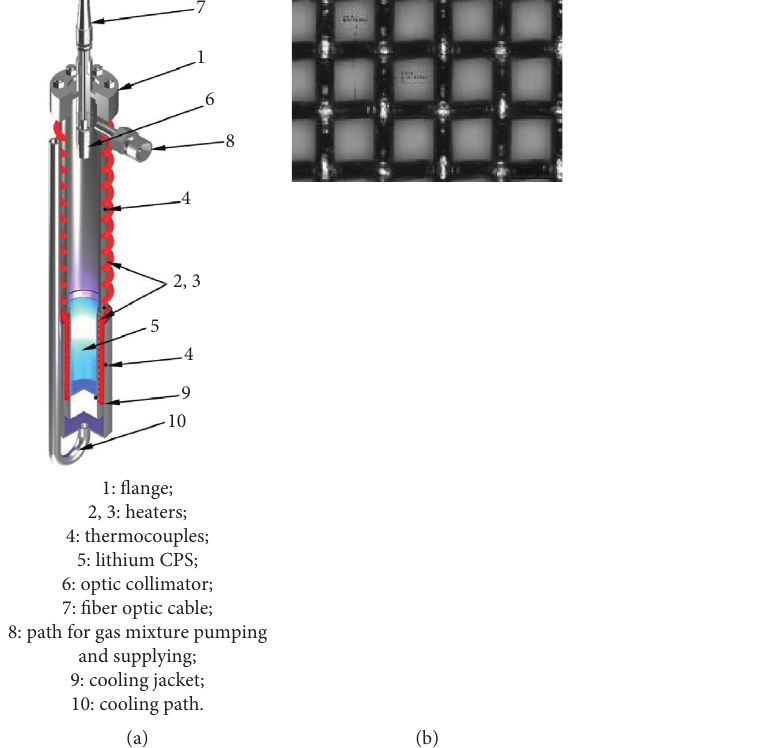
Figure 1: The experimental device with lithium CPS. (a) 3D view of the experimental device with (b) enlarged image of the CPS matrix lithium CPS.